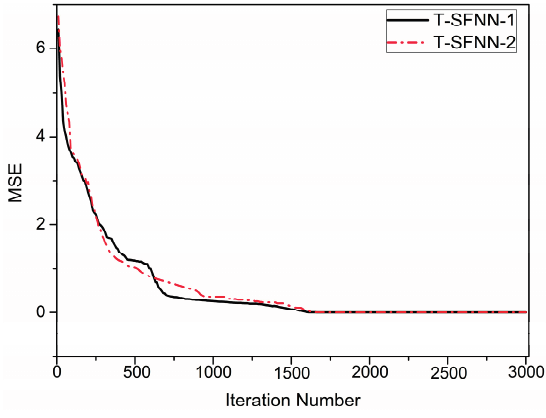
Figure 5. MSE curves based on IPSO for T-SFNN-1 and T-SFNN-2.